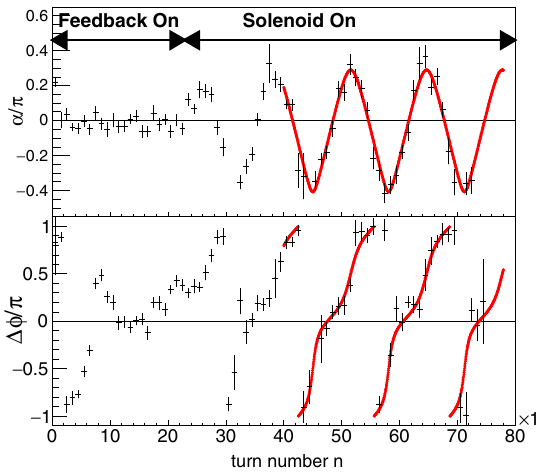
FIG. 4. Analytical solutions [Eq. (4)] for the off-resonance case q ¼ 0 . 5 . The other parameters are the same as in Fig. 3.